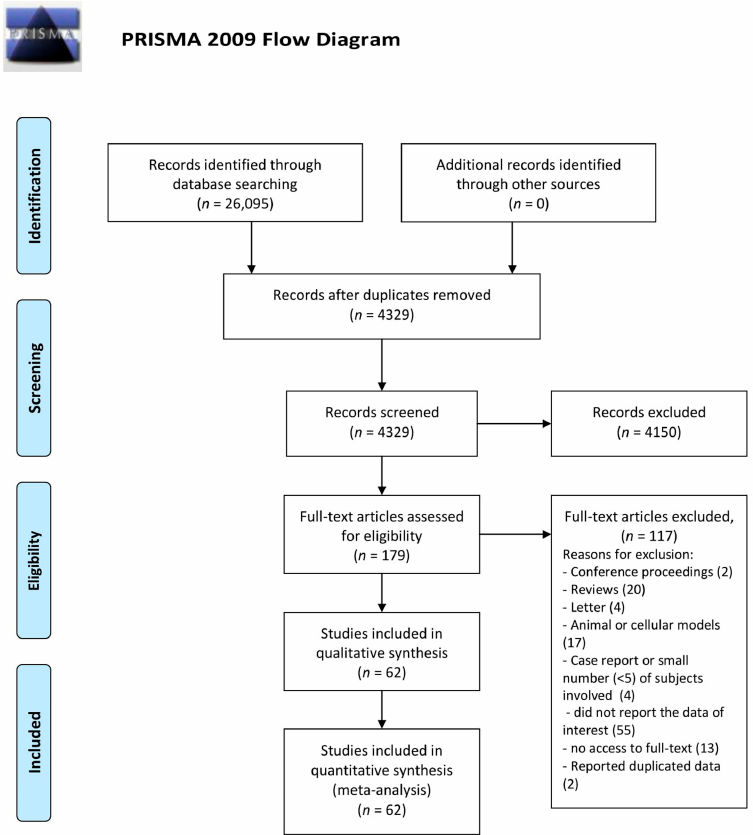
Figure 1. PRISMA flowchart diagram describing the systematic reviews process. PRISMA = Preferred Reporting Items for Systematic reviews and Meta-Analyses.